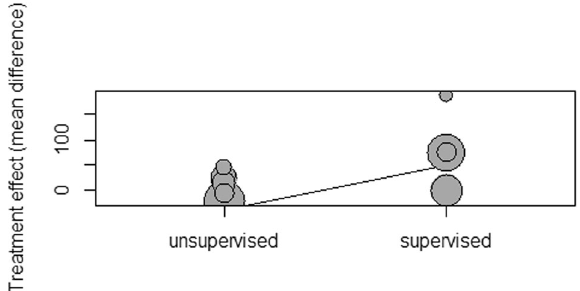
Fig. 5 Bubble plot for supervision meta-regression adjusted for supervision, setting and programme